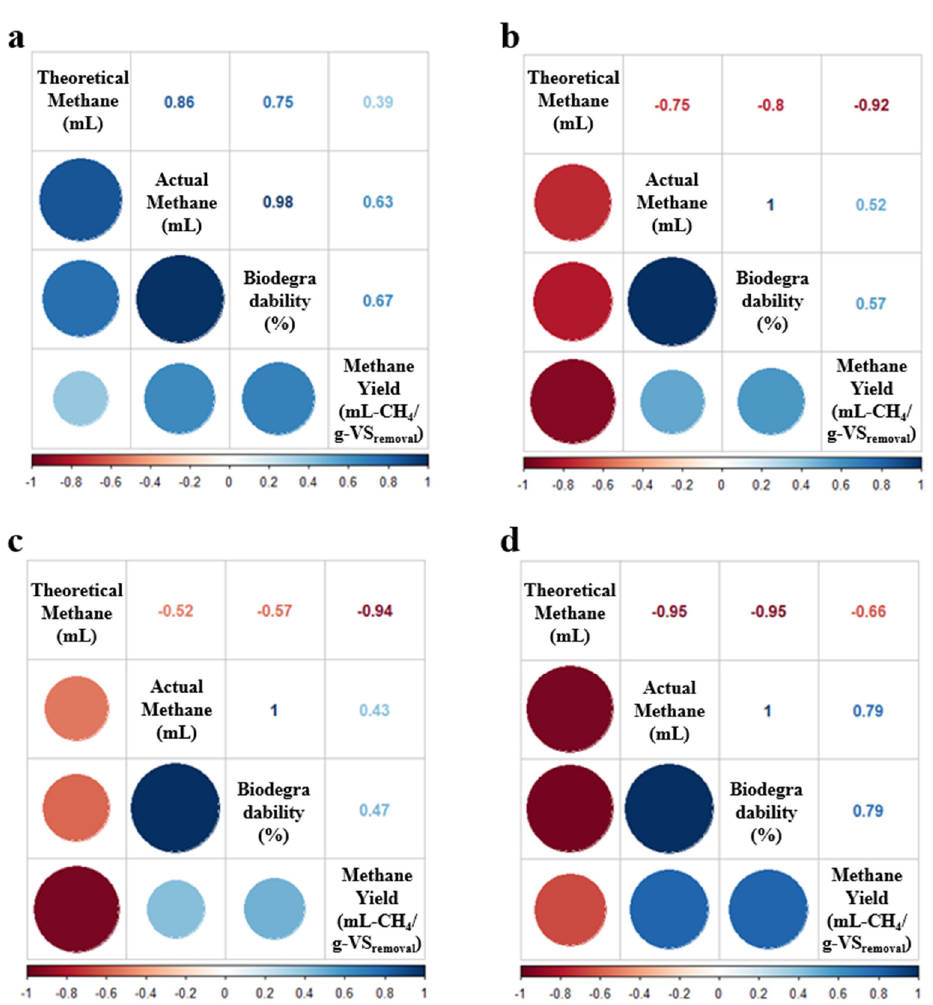
Figure 2. Correlation between environmental variables (Spearman’s correlation coefficient): ( a ) total; ( b ) sewage sludge; ( c ) food waste; ( d ) livestock manure.